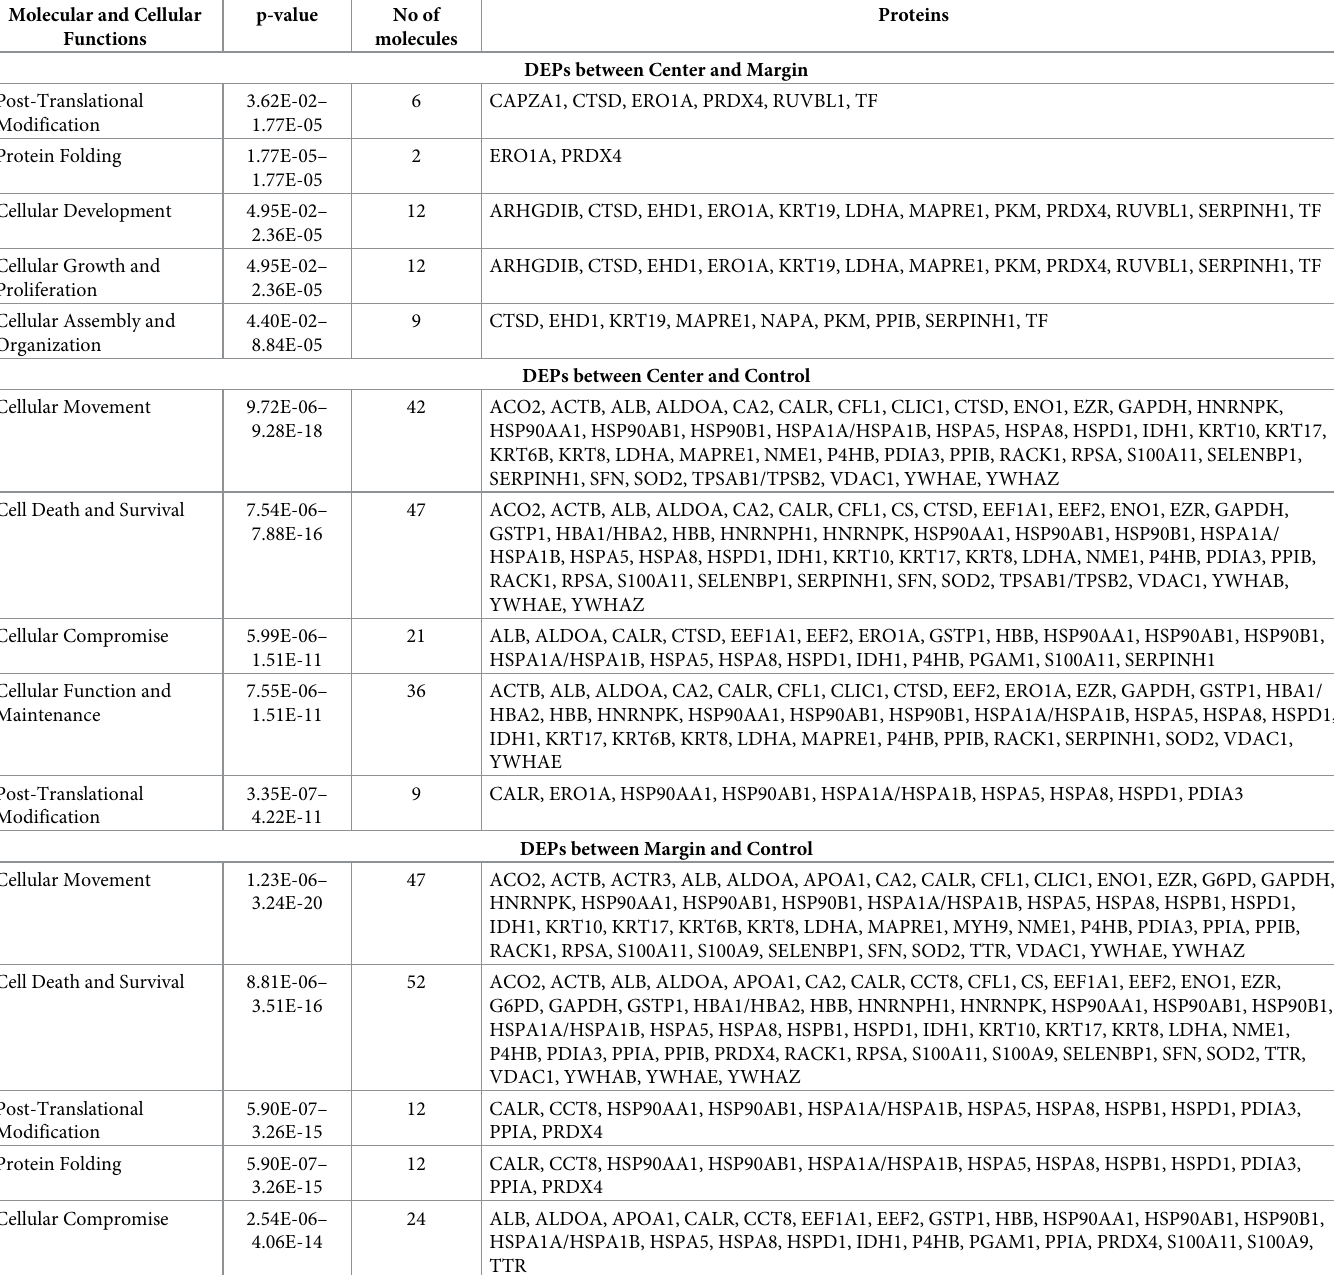
Table 6. Molecular and cellular functions of differentially expressed proteins (DEPs) in SCC tumor. Molecular and Cellular